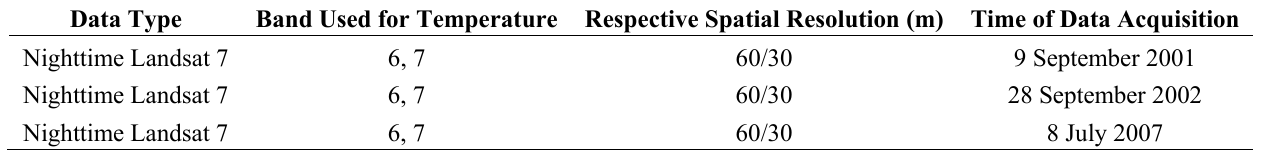
Table 1. The Landsat data used for temperature retrieval to coal fire detection and monitoring in the study.